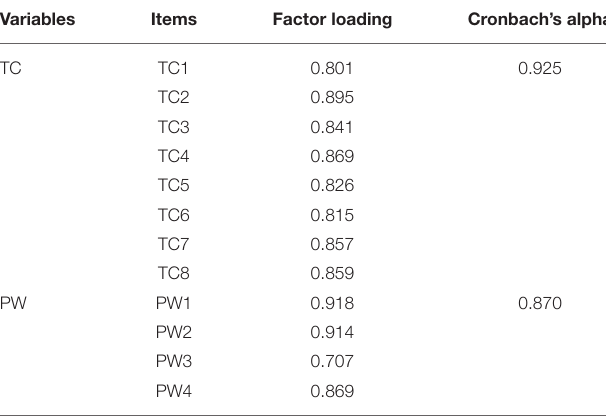
TABLE 1 | The results of confirmatory factor analysis and Cronbach’s alpha coefficients.